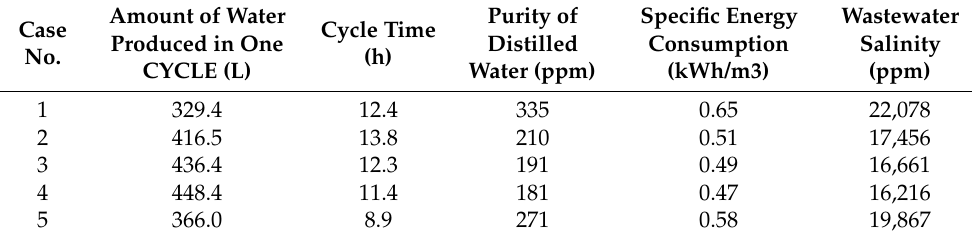
Table 3. CDI output: productivity, purity, cycle time, specific energy consumption, and wastewater salinity for five cases of feed